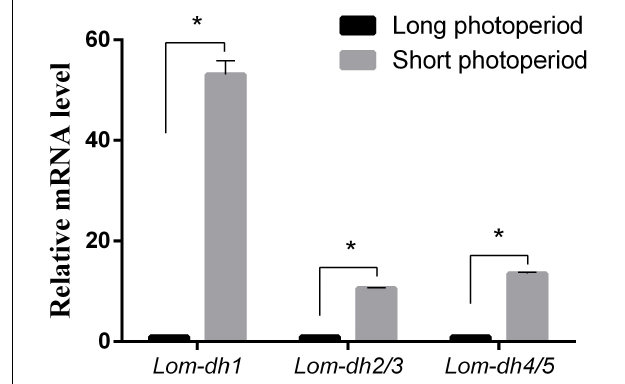
FIGURE 4 | Relative mRNA level of Lom-dh genes detect in L. migratoria under long and short photoperiod. ∗ Indicates an error probability of p < 0.05 by Student’s t -test.